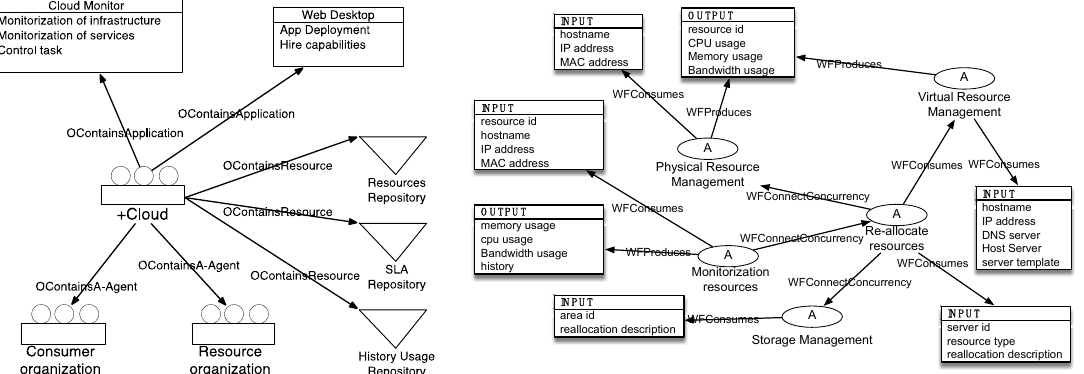
Figure 2. ( Left ) The structure of the suborganizations (consumption and supply), data repositories and control devices; ( Right ) Shows the activity of the infrastructure control service.